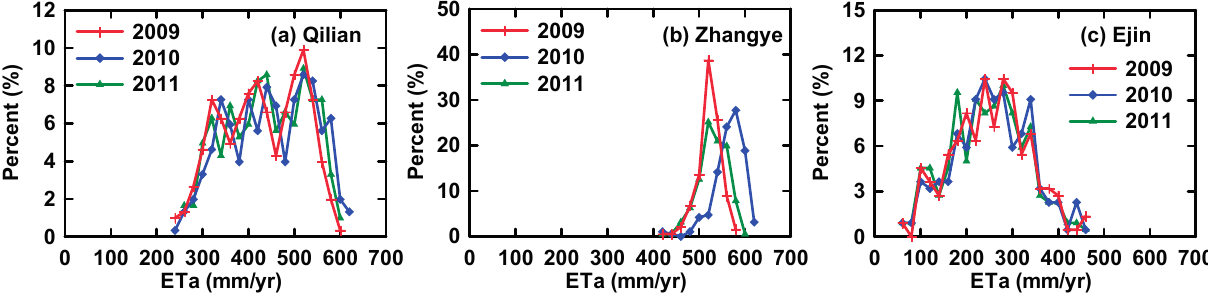
Figure 9. Histograms of the annual ETa in the ( a ) upstream (Qilian), ( b ) middle stream (Zhangye), and ( c ) downstream (Ejin) regions illustrated in Figure